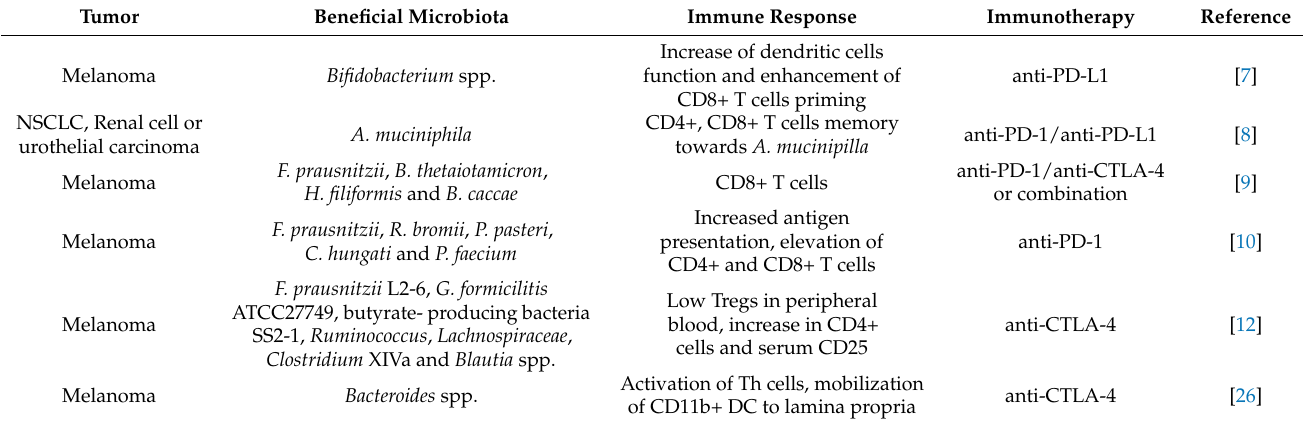
Table 1. Bacterial species associated with enhancement of immunotherapy in solid